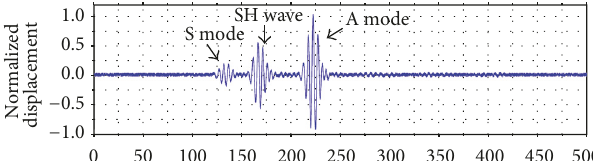
Figure 5: Ellipse determined by individual transmitter-receiver